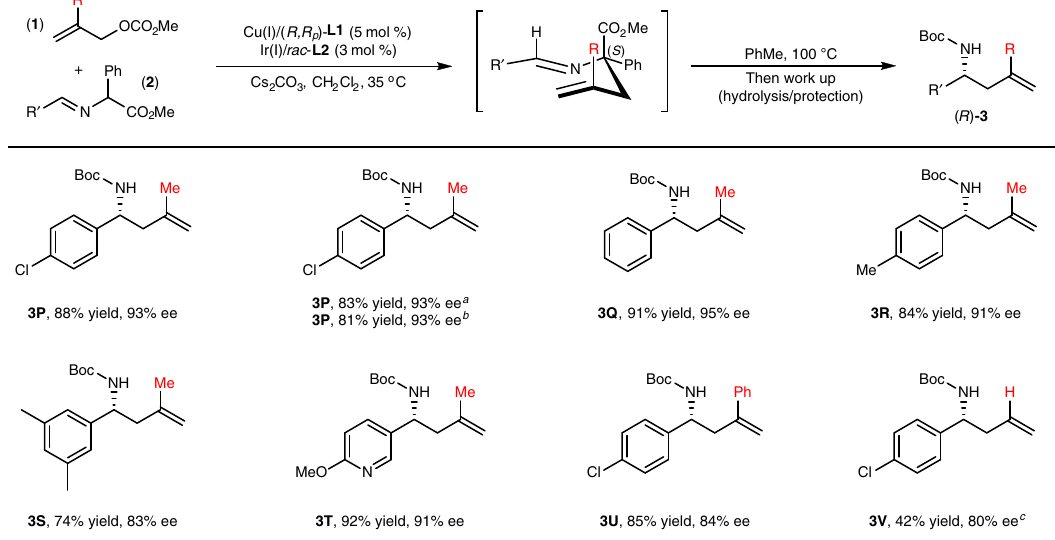
Fig. 7 Substrate Scope of 2-Substituted Prop-2-en-1-yl Carbonates. Reactions conditions: 1 (0.20 mmol), 2 (0.30 mmol), Cu(I)/( R,R p )- L1 (0.01 mmol), Ir (I)/ rac - L2 (0.006 mmol), CH 2 Cl 2 (1 mL), N 2 , 35 o C, 36 – 48 h. Isolated yields were shown. Ee values were determined by HPLC analysis. a [Cu(I)/( R,R p )- L1 + Ir(I)/( S,S,S )- L2 ] complexes were used as the catalyst. b [Cu(I)/( R,R + Ir(I)/( R,R,R )- L2 ] complexes were used as the catalyst. c α -Naphthalen-1-yl p )- L1 substituted aldimine ester 2y was used